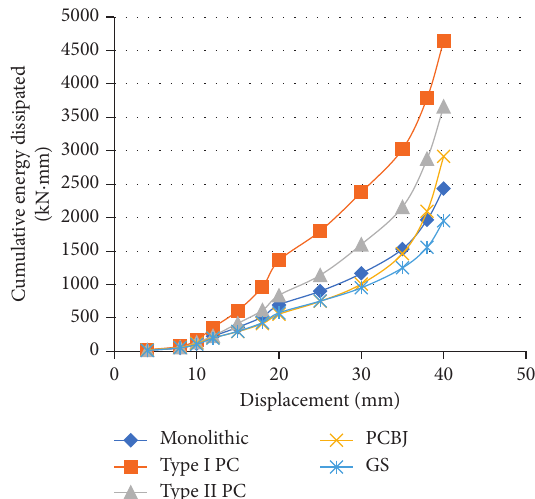
Figure 17: Cumulative energy dissipation of all specimen.